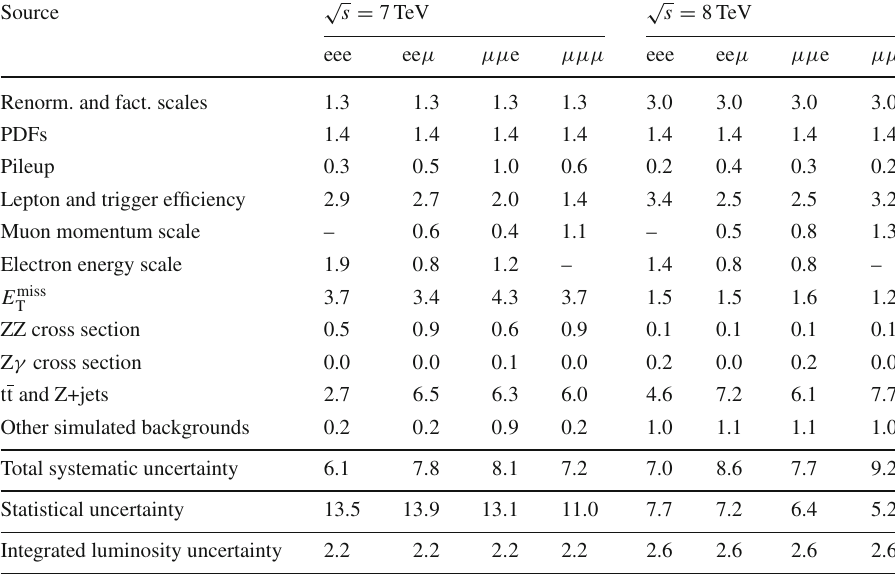
Table 2 Summary of relative uncertainties, in units of percent, in the WZ cross section measurement at 7 and